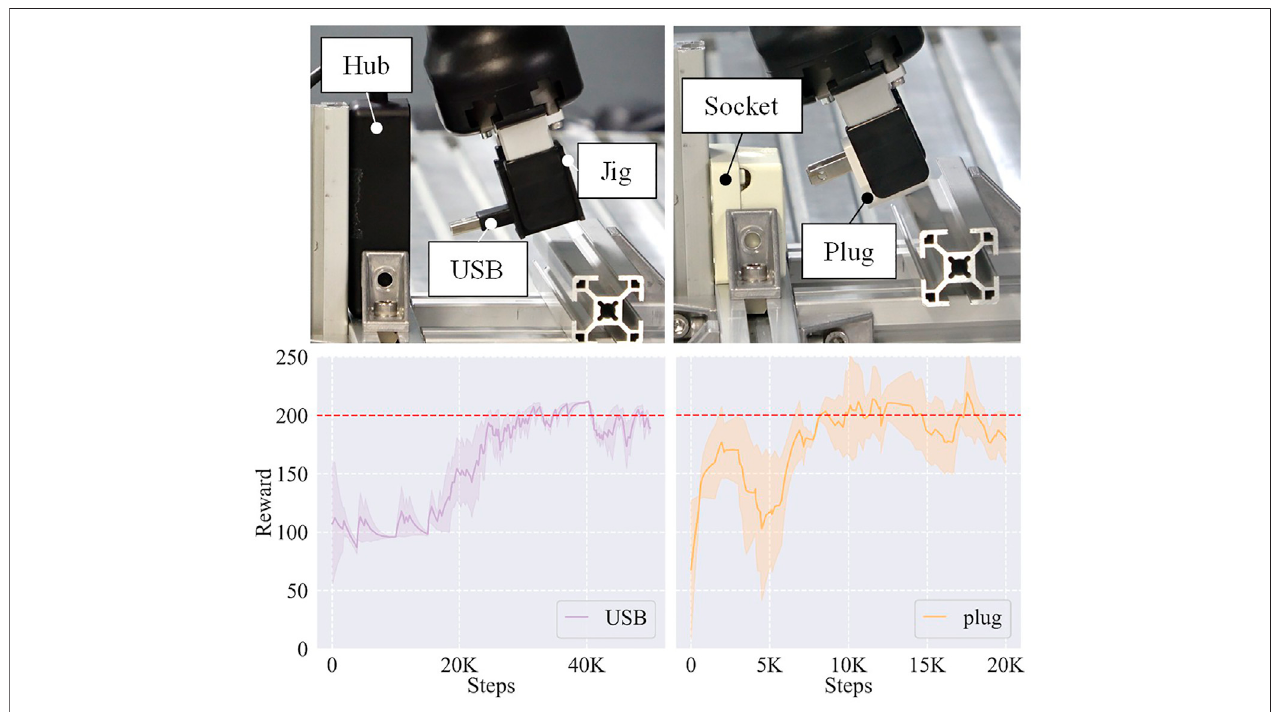
FIGURE 10 | Two real assembly tasks and their learning curves. Left: USB insertion task. Right: plug insertion task. The objects are grasped by the gripper. A jig is used in the USB insertion to improve the stability considering the contact area between the USB and the gripper.